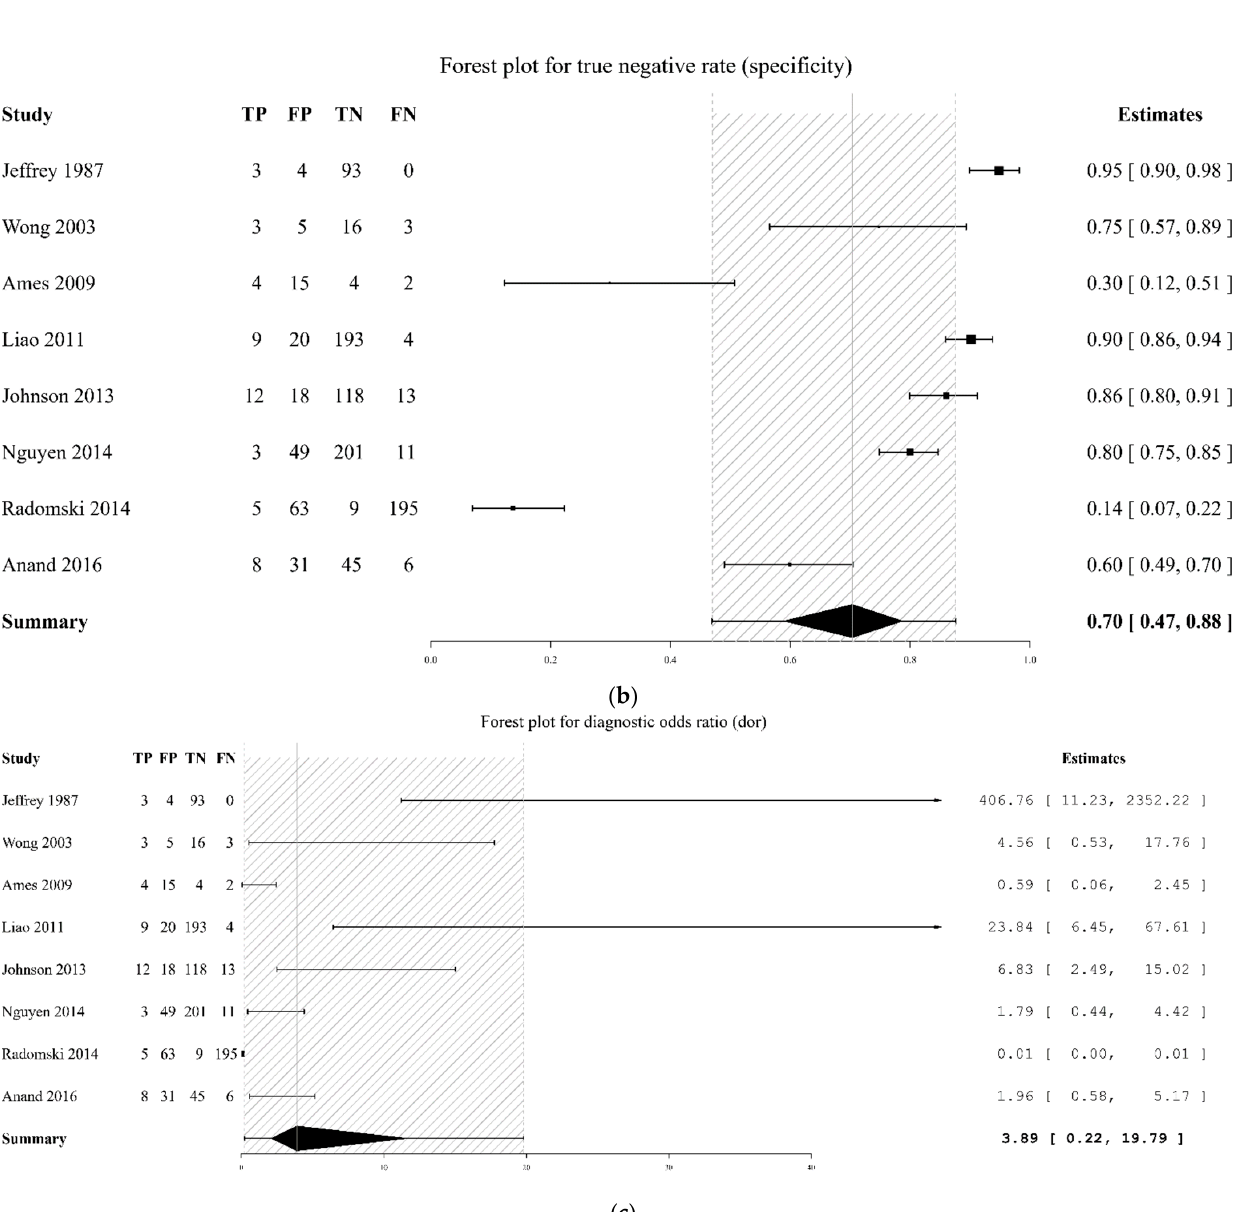
Figure 4. Forest plot of sensitivity ( a ), specificity ( b ), and diagnostic odds ratio ( c ) for mortality after computed tomography. The values of true positive (TP), false positive (FP), true negative (TN), and false negative (FN) are shown. The model-based mean estimates with 95% credible intervals are also shown [15–17,19,20,23–25].